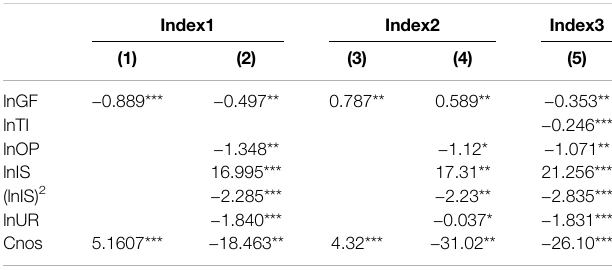
Table 10 indicates the results related to the stated hypotheses (H1 and H2) of this study and the coef fi cient estimates of variables to explore the direct relationship between green fi nance and carbon emission with the moderating role of technological innovation in this relationship. Models 1 and 2 examine the impact of green fi nance on carbon emission. Model 1 shows that the green fi nance impact is negative on carbon emission at a signi fi cance level of 1% and a coef fi cient value of − 0.889 without control variables. Model for the carbon emission added control variables. Therefore,